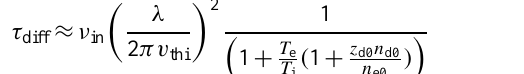
Fig. 2. The time evolution of electron irregularities during radio wave heating with varying (a) electron density and (b) ion-neutral collision frequency utilizing the computational model for a radar frequency of 56MHz. The heating is turned on at 25 seconds.